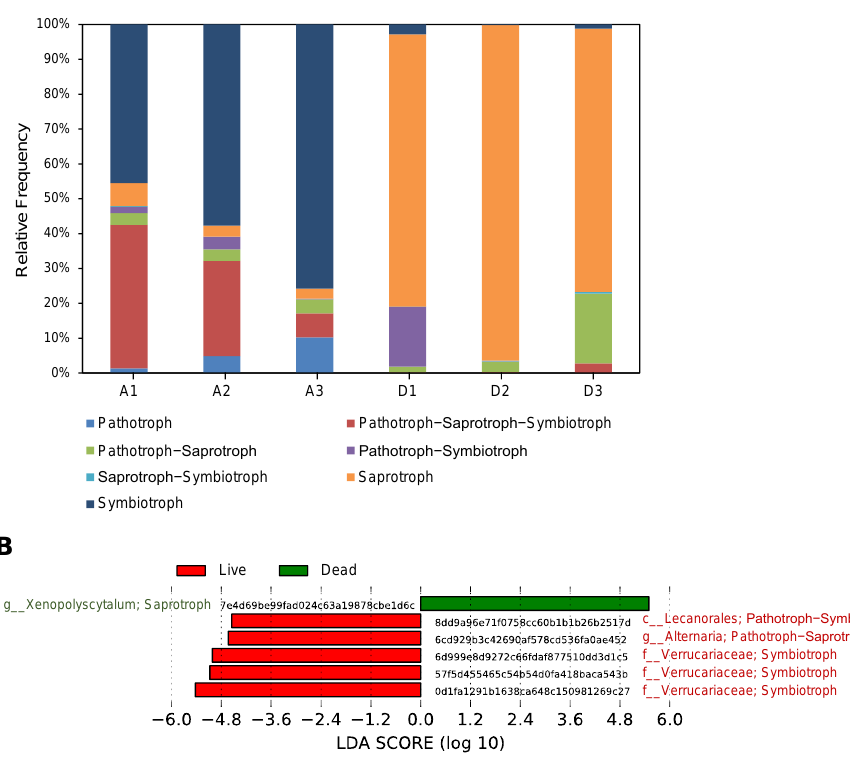
Figure 6. Relative abundance of predicted functional fungal communities from live and dead Korean fir trees. ( A ) Relative abundances of fungal trophic modes in live and dead trees. A1 to A3 indicate live tree and D1 to D3 indicate dead tree. ( B ) Differentially abundant fungal ASVs between live and dead trees. Differentially abundant fungal ASVs were analyzed using LEfSe with a linear discriminant analysis (LDA score) > 2.0 and a p < 0.05. “ c__ ” indicates Class, “ f__ ” indicates Family, and “ g__ ” indicates Genus. Fungal trophic modes were predicted using FUNguild.